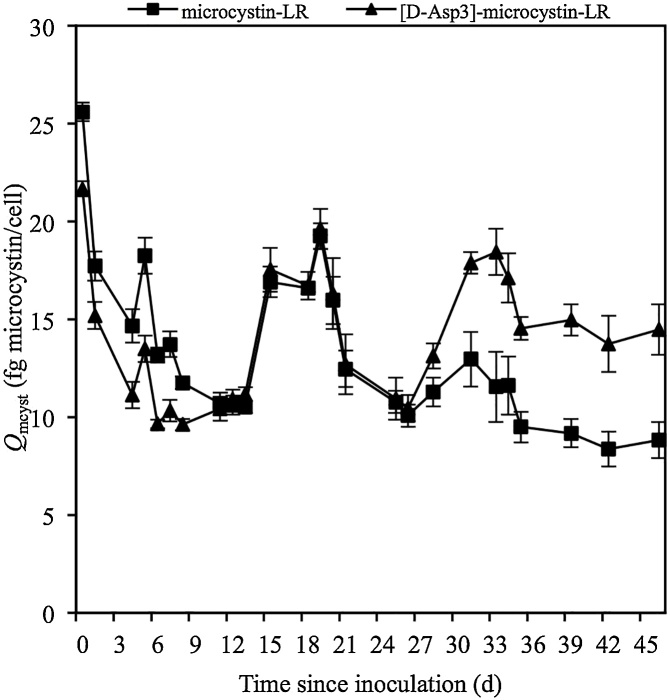
Microcystin cell quotas (Qmcyst) averaged for microcystin-LR and [D-Asp3]-microcystin-LR, respectively, produced by Microcystis aeruginosa CPCC 300 since time of inoculation.